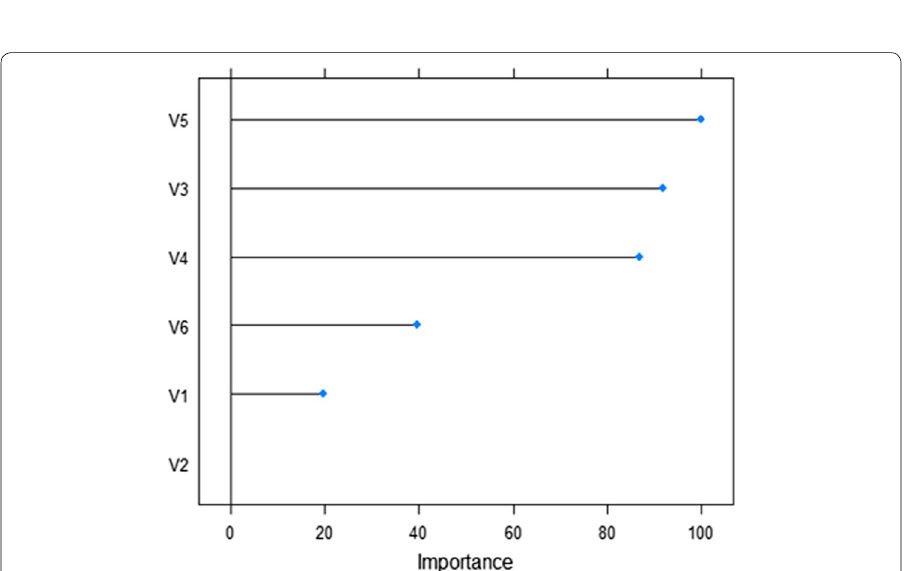
Fig. 9 Feature selection and classification method combination for Car Evaluation Dataset a RF RF SVM and c RF KNN + +